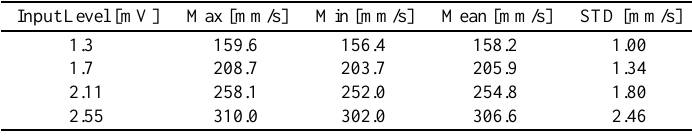
Speaker Cone’s speed using excitation frequency for various amplitude levels